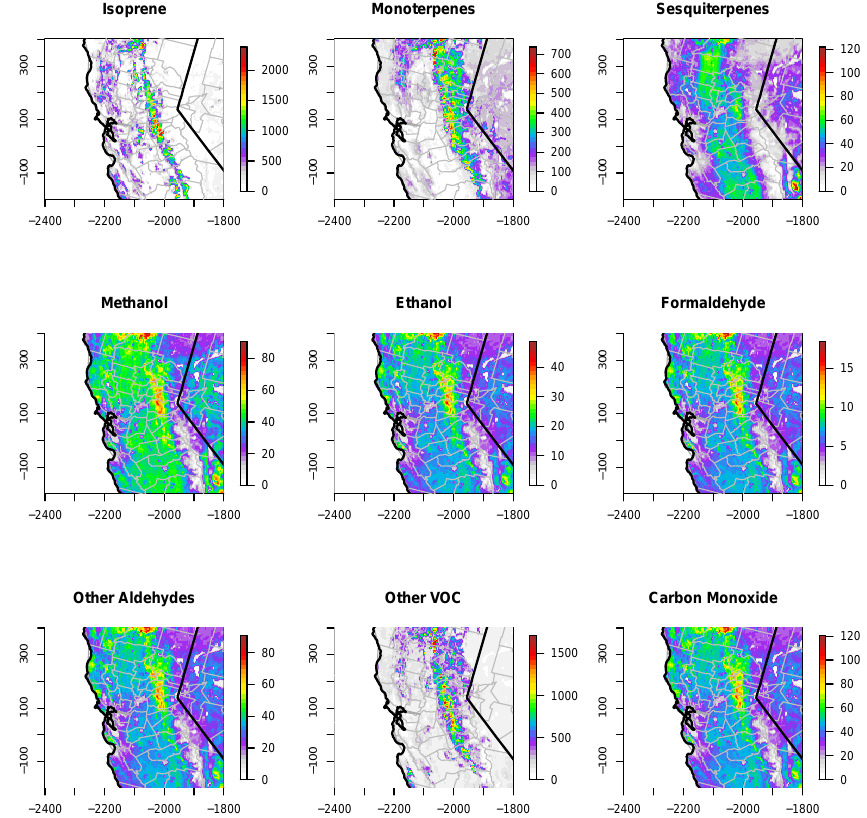
Figure 4. BEIS 3.61/BELD 4 estimated total emissions (tons) for the modeling period.